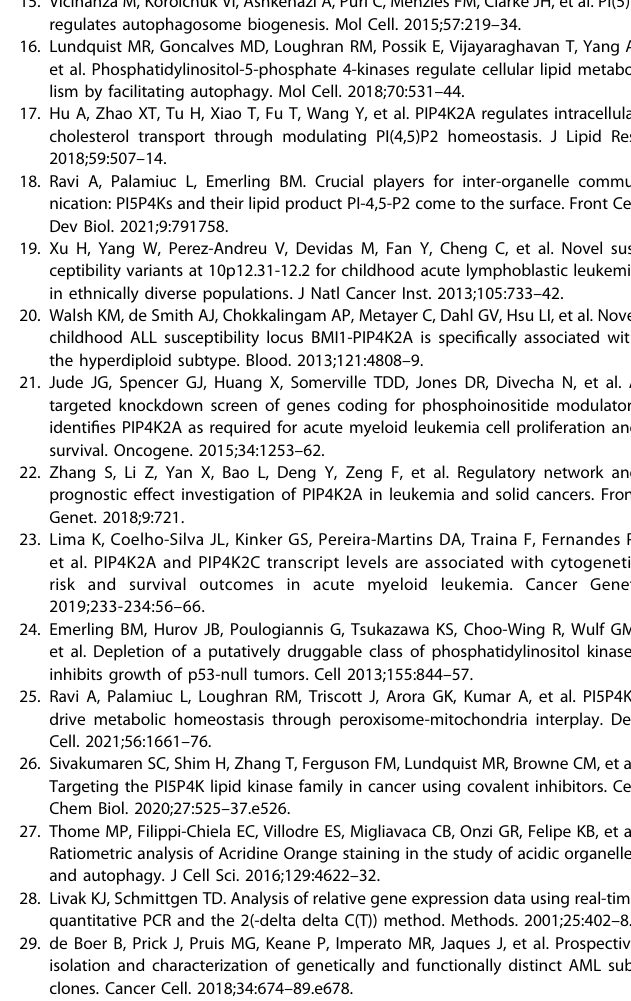
Fig. 5 Pharmacological PIP4K2s inhibition selectively reduces cell viability of primary leukemic blasts. A Dose-response cytotoxicity was analyzed using a methylthiazoletetrazolium (MTT) assay in samples from acute myeloid leukemia (AML) or T- and B-acute lymphoblastic leukemia (T- or B-ALL) patients treated with vehicle or increasing concentrations of THZ-P1-2 (1.6, 3.2, 6.4, 12.5, 25, 50, and 100 μ M) for 72 h. Values are expressed as the percentage of viable cells for each condition relative to vehicle-treated cells. The IC 50 values for each patient sample are described. B Apoptosis was detected by fl ow cytometry in gated human Sca1 - CD45 + CD34 + (or CD117 + cells for NPM1 -mutant AMLs) of acute myeloid leukemia (AML) samples in a co-culture system using a FITC-annexin V/DAPI staining method. Cells were treated with vehicle, cytarabine (AraC, 250 and 500 nM), venetoclax (VEN, 100 and 500 nM), and/or THZ-P1-2 (3.2 or 6.4 μ M) for 72 h. Bar graphs represent the mean ± SD of all the independent patients screened, each point represents a patient. The p values are indicated in the graphs; * p < 0.05, ** p < 0.01, *** p < 0.0001; ANOVA and Bonferroni post-test. C Correlation analysis of THZ-P1-2 response with clinical, laboratory, molecular, and metabolic characteristics of the samples. Note that THZ-P1-2 responsiveness (area under curve, AUC) was clusterized with markers of mitochondrial metabolic markers (Levels of MMP in the blasts – Blast_TMRE; Basal OCR and Max OCR). Data were processed using the Morpheus platform (https://software.broadinstitute.org/morpheus/) D Association of THZ-P1-2 sensitivity (area under the curve, AUC), mutations in FLT3 , NPM1 , and RUNX1 , and European LeukemiaNet (ELN) risk strati fi cation. E Evaluation of long-term proliferation in neonatal cord blood (CB) CD34 + and primary AML mononuclear cells using a co-culture system. Data were expressed as mean ± SD of at least three independent experiments. The time points and p values are indicated in the gra p hs; * p < 0.05, ** p < 0.01, *** p < 0.0001; ANOVA and Bonferroni post-test. F Neonatal cord blood (CB) CD34 + cells were plated in cytokine-supplemented methylcellulose in the presence of vehicle or THZ-P1- 2 (3.2 or 6.4 μ M). Colonies were counted after 8 – 14 days of culture and are represented as the percent of vehicle-treated controls. Bars indicate the mean ± SD of at least three assays. G , H Mitochondrial membrane potential was detected by fl ow cytometry in gated human CD45 + CD34 + (or CD117 + for NPM1 -mutant AMLs)/annexin V − from samples from acute myeloid leukemia (AML) in a co-culture system using the TMRE staining method. Cells were treated with vehicle, cytarabine (AraC, 250 nM), venetoclax (VEN, 100 or 500 nM), and/or THZ-P1-2 (3.2 [alone or in combination with VEN 100 nM] or 6.4 μ M) for 72 h. Bar graphs represent the mean ± SD of at least three independent experiments, each point represents a patient. The p values are indicated in the graphs; * p < 0.05, ** p < 0.01, *** p < 0.0001; ANOVA and Bonferroni post-test. I Differently ex p ressed proteins obtained from THZ-P1-2 (THZ)-sensitive ( n = 3) and THZ-resistant ( n = 3) AML patients were included in the heatmap (all false discovery rate (FDR) q values (FDR q ) <0.25). AML patients with higher AUC were considered resistant to THZ-P1-2. J The bar graph represents the normalized enrichment scores (NES) for Hallmark, Reactome, and Kegg gene sets with FDR q < 0.05. K GSEA plots for enriched molecular signatures in THZ-P1-2 (THZ) resistant vs . sensitive AML patient ’ s proteome are also shown. NES and FDR q are